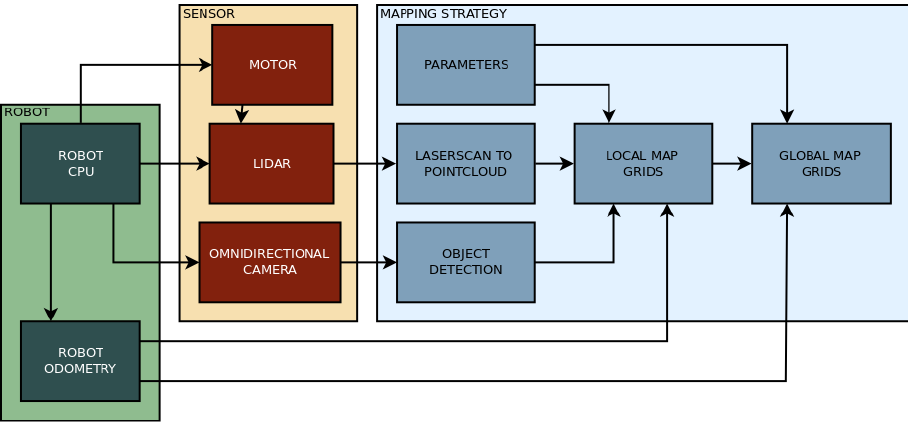
Figure 6. Flow chart of the proposed mapping